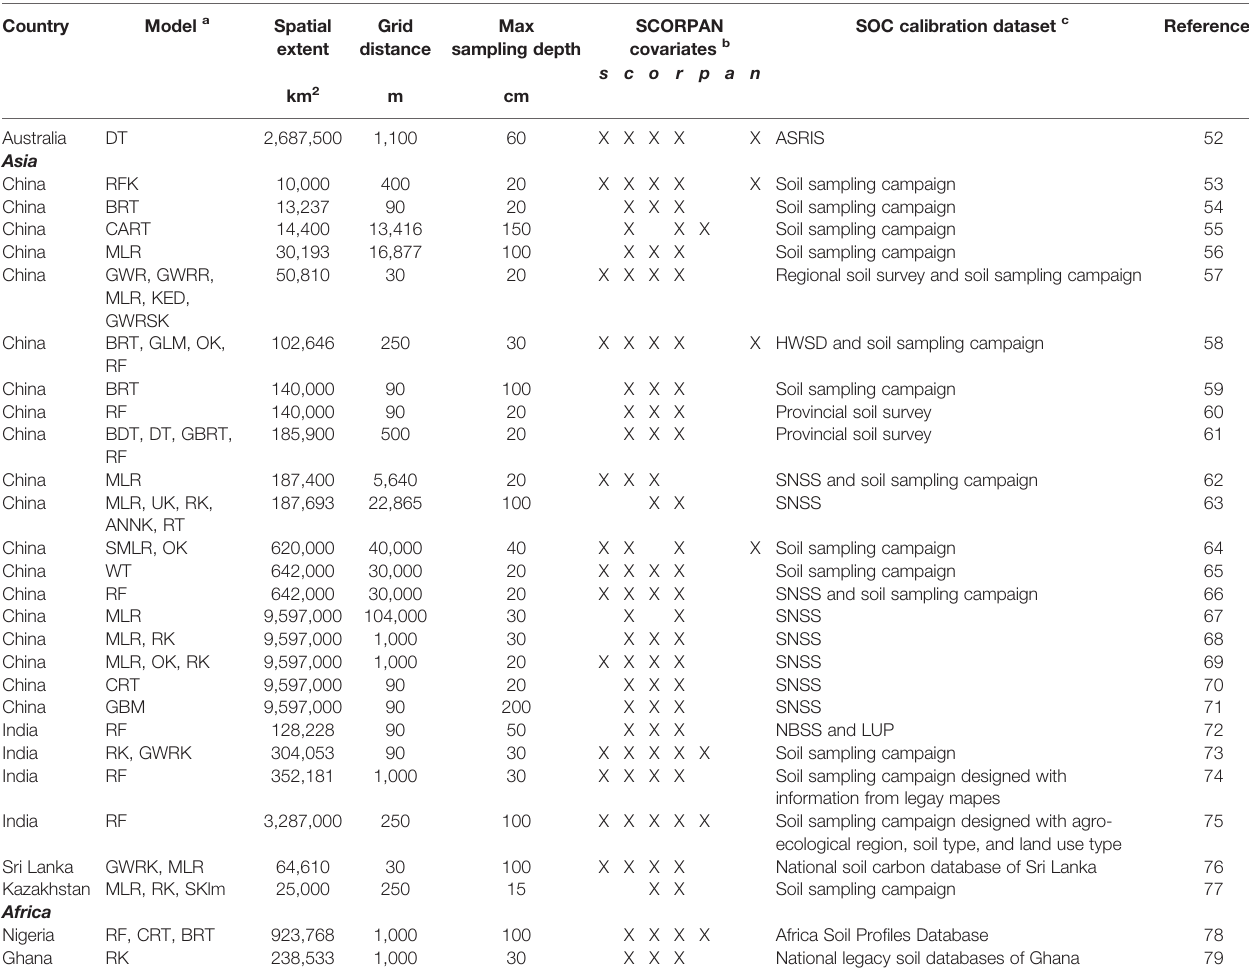
a ANNK,arti fi cialneuralnetworkwithkriging;BDT,baggingdecisiontree;BRT,boostedregressiontrees;CART,classi fi cationandregressiontree;CIF,conditionalinferenceforests;CNN,convolutional neural networks; CRT, cubist regression tree; DT, decision tree; GBM, gradient boosting machines; GBRT, gradient boosting regression tree; GLM, general linear model; GWR, geographically weightedregression;GWRK,geographicallyweightedregressionkriging;GWRR,geographicallyweightedridgeregression;GWRSK,geographicallyweightedregressionsimplekriging;IDW,inverse distanceweight regression;KED,kriging withanexternal drift;LASSO, leastabsoluteshrinkage andselectionoperatorregression;LMM,linearmixedmodel;MARS,multivariate